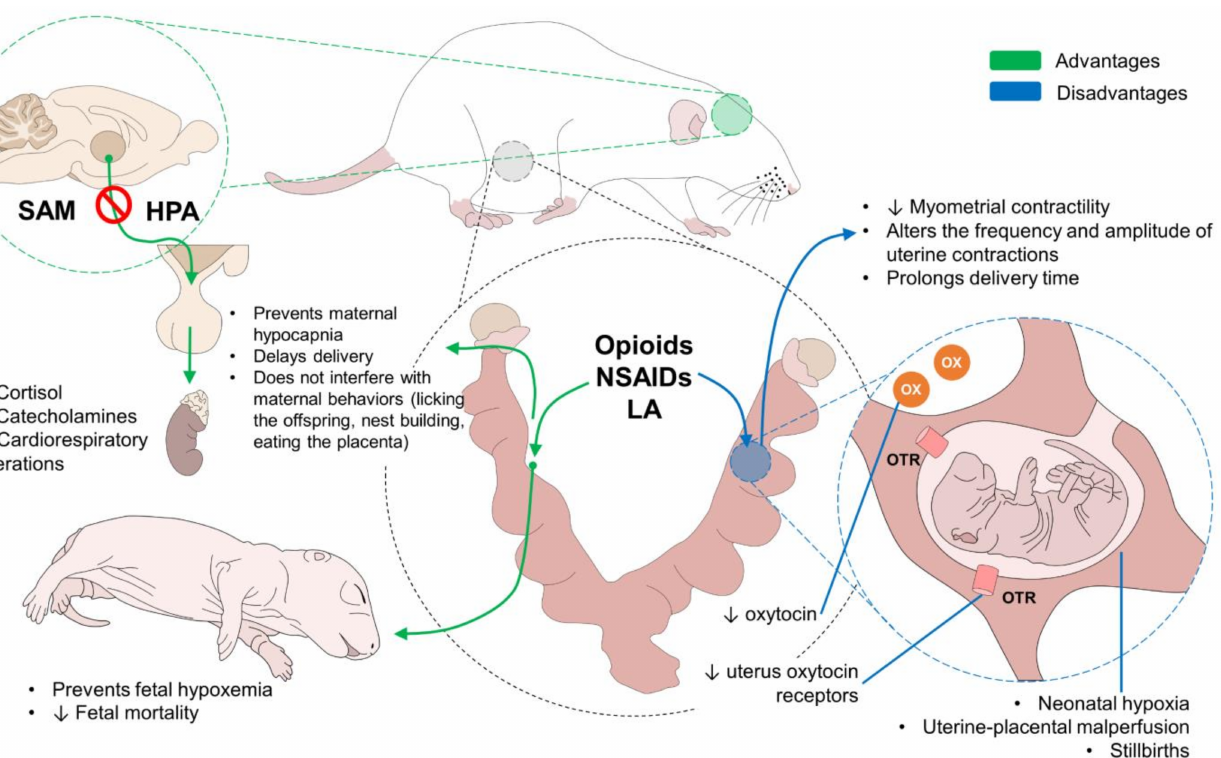
Figure 4. Summary of advantages and disadvantages of analgesia in parturition. Opioids, NSAIDs, and LA can have beneficial or detrimental effects on the mother and the newborn. However, since these actions differ between species and individuals, an appropriate analgesic protocol must consider these factors from a pharmacological point of view. Advantages such as the prevention of hypocapnia and hypoxemia in the dam and the offspring, respectively, are marked in green inside the figure. Disadvantages such as a decrease in OX and OTR are marked with blue. HPA: hypothalamus– pituitary–adrenal axis; LA: local analgesics; NSAIDs: non-steroidal anti-inflammatory drugs; OTR: oxytocin receptors; OX: oxytocin; SAM: sympathetic–adreno–medullary